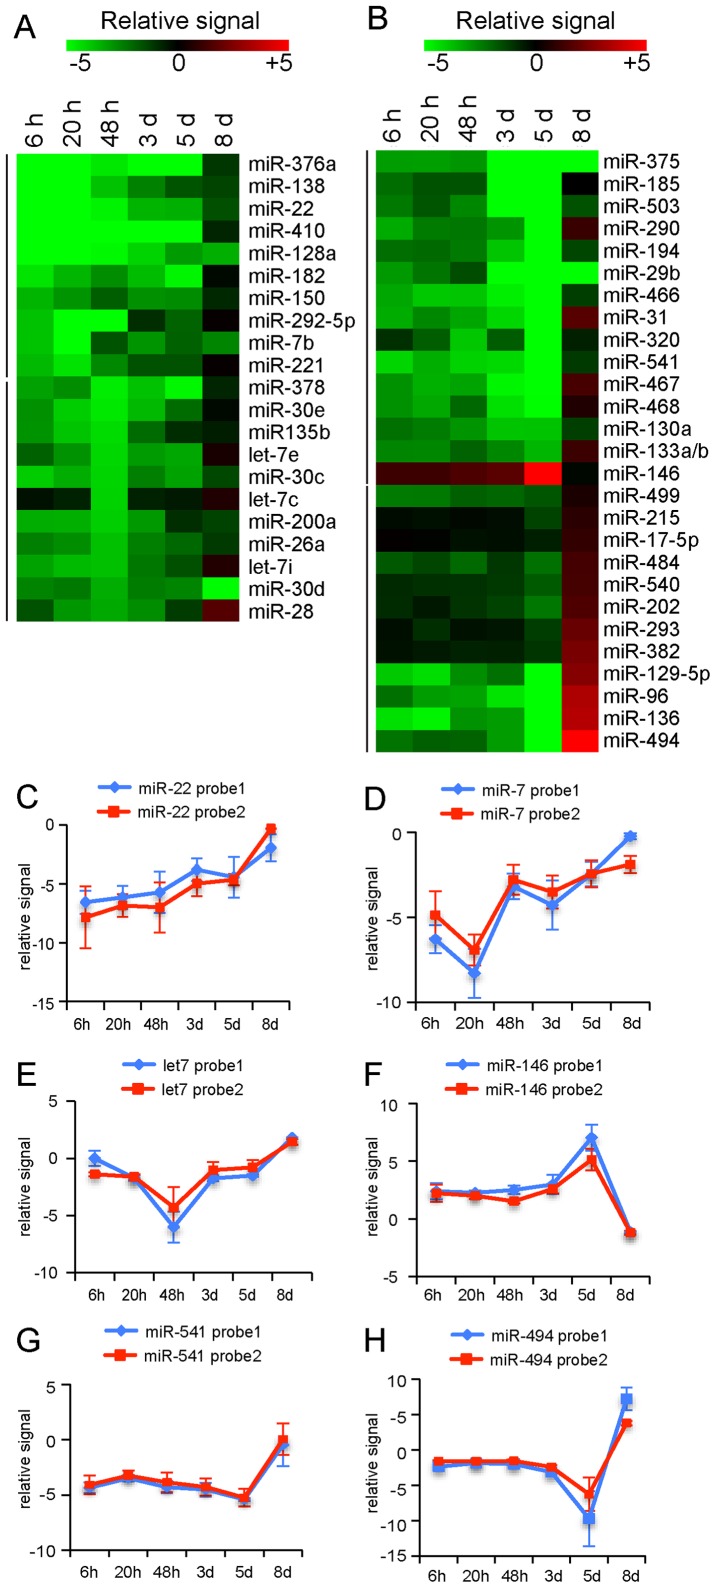
miRNA expression is regulated during early and late neuronal development.A–B) Heat maps showing relative expression levels of miRNAs in hippocampal neurons at 6 h, 20 h, 48 h, 3 day and 5 days compared to mature neurons (21 days) after plating in a green (negative fold-change) to red (positive fold-change) scale. Selection criteria; in all samples an absolute fold change value greater than or equal to 5 for negative fold changes P<0.01 and 1.5 for positive fold changes (P<0.05). Expression levels of miRNAs that are changed during early development (6 hours –48 hours) are shown in (A). Expression levels of miRNAs that are altered during late development (3 days –8 days) are shown in (B). (C–H) Graphs of relative signals (normalized fold changes) of miRNA expression during early neuronal development (C–E) and late neuronal differentiation (F–H). The blue and red lines indicate the two probes used to detect the expression of indicated miRNAs, which were spotted in duplicate on the LNA array.